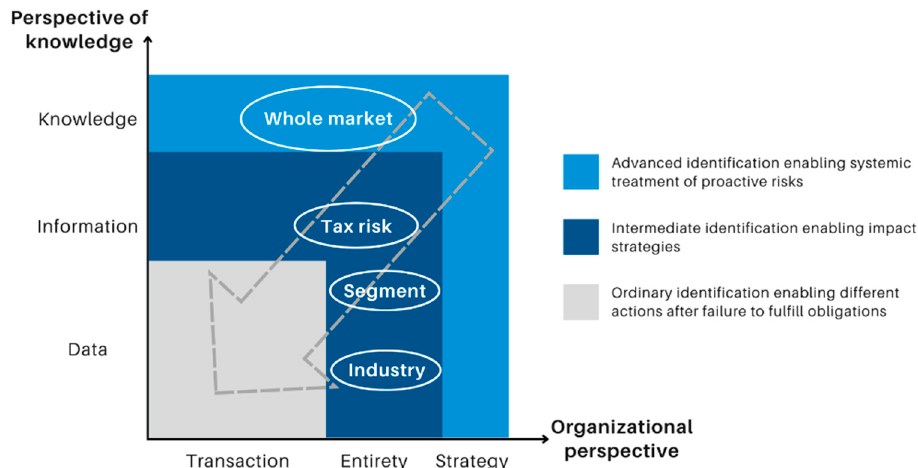
Figure 3. Tax risk analysis model (risk identification levels).